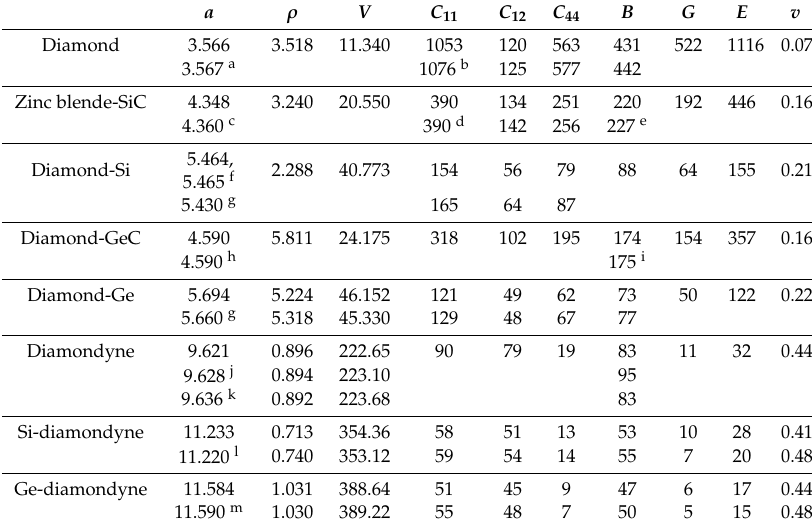
Figure 2. The ( a ) lattice parameters, ( b ) the volume of primitive cell, ( c ) bond lengths and ( d ) elastic moduli of diamond, zinc blende-SiC, diamond-GeC, diamond-Si, diamond-Ge, diamondyne, Si-diamondyne and Ge-diamondyne. Table 1. The lattice parameters a (Å), density ρ (g / cm 3 ), volume of primitive cell V (Å 3 ), elastic constants (GPa), and elastic moduli (GPa) of diamond, zinc blende-SiC, diamond-GeC, diamond-Si, Diamond-Ge, diamondyne, Si-diamondyne and Ge-diamondyne.